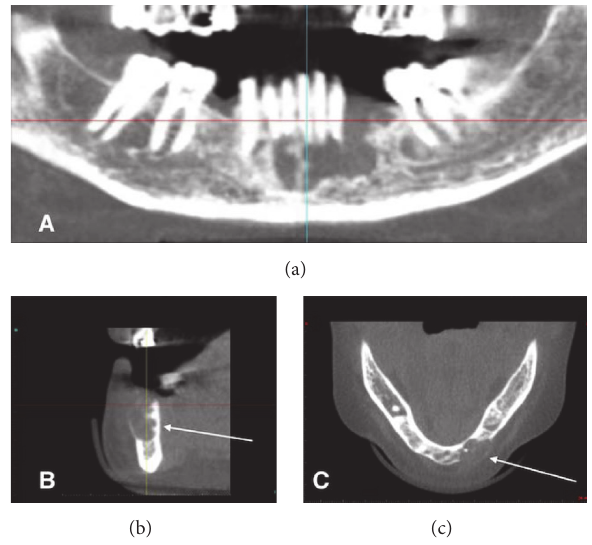
Figure 2: Relapse of the lesion. (a) The next examination, three months later, revealed the presence of a radiolucent cyst-like lesion in the mandible with mildly defined and irregular borders. (b) The CT radial view showed lingual cortical plate with a polylobate appearance and erosion of the buccal cortical plate (arrow). (c) The CT axial view highlighted the buccal erosion of the cortical plate